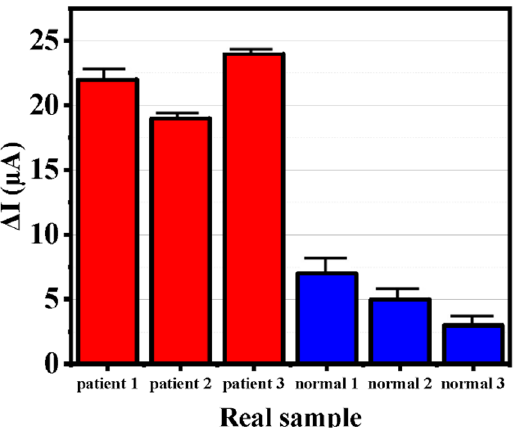
Figure 9. Real sample test results based on SWV techniques. Table 1. Comparison of the provided biosensor with other studies for CA 15.3 detection.